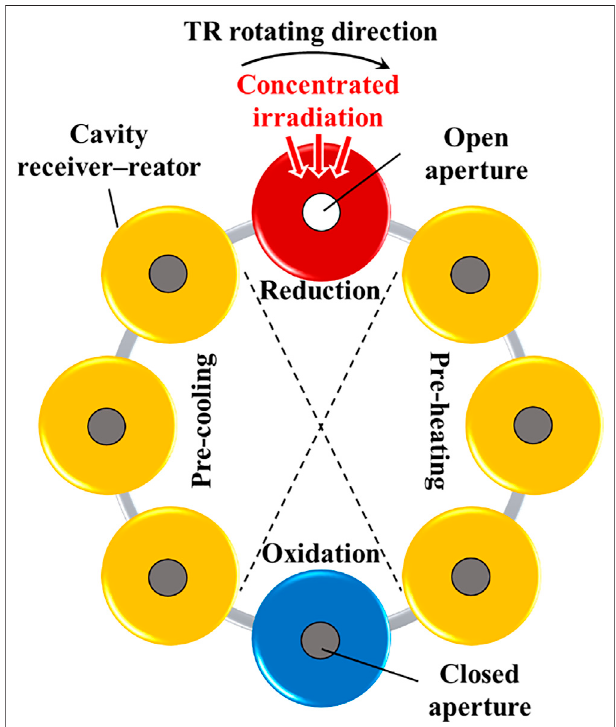
FIGURE 2 | Schematic of an example array of 8 receiver – reactors. The gas-phase heat exchangers and the related connecting devices are not shown in the fi gure. This fi gure is adapted from (Li et al.,